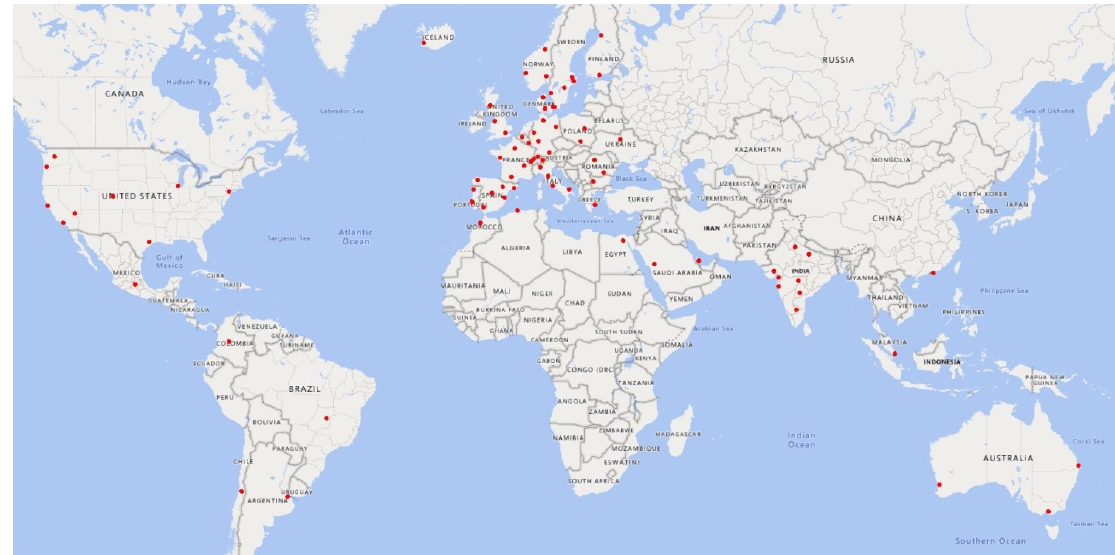
Figure 2. The simulated locations for techno-economic analysis.